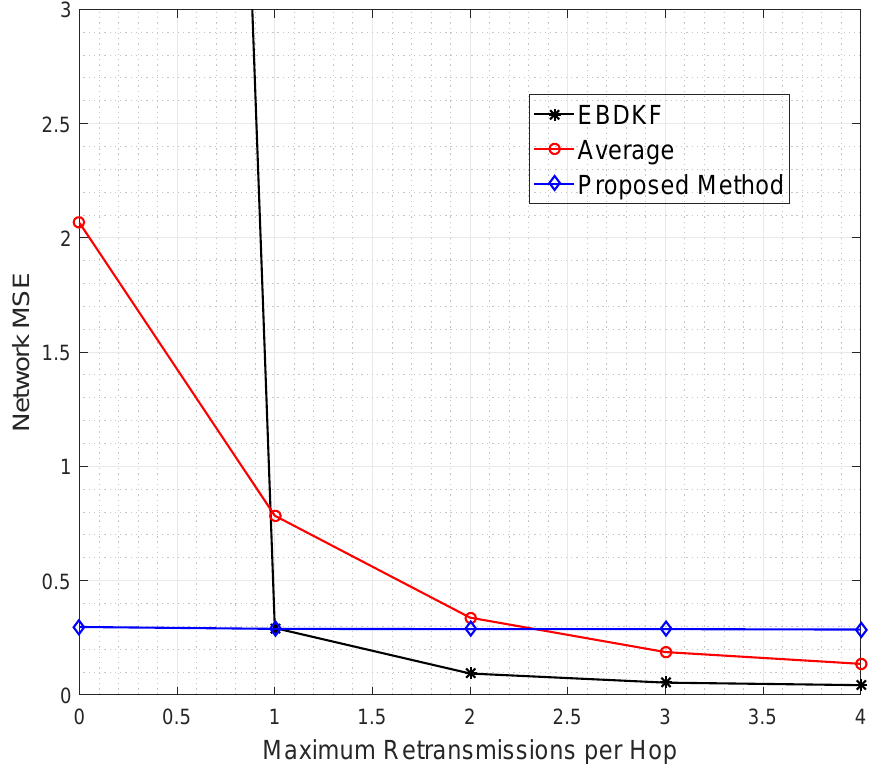
Figure 8. The performance comparison among the proposed statistical, AVG, and EBDKF information fusion methods in a retransmission allowed chain IoT